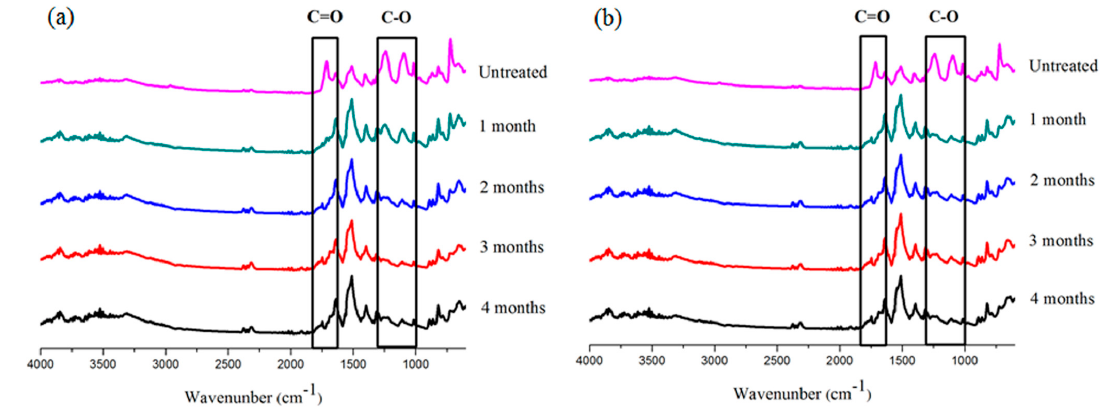
Figure 7. FT-IR spectra of nonwoven geotextiles that are immersed in NaOH at ( a ) 23 ˝ C and ( b ) 50 ˝ Figure 7. FT ‐ IR spectra of nonwoven geotextiles that are immersed in NaOH at (a) 23 °C and (b) 50 °C.